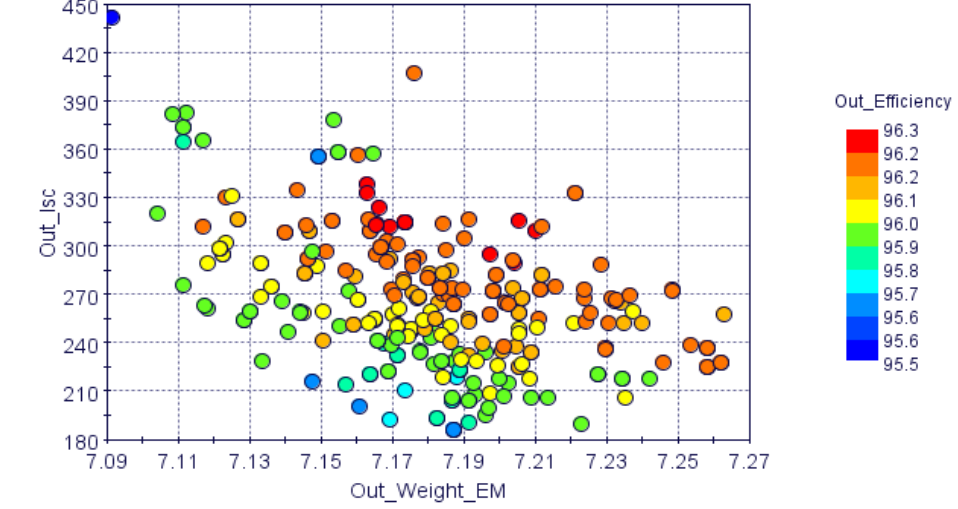
Figure 4. Visualization results of a feasible design in the 18 slot/12 pole combination.